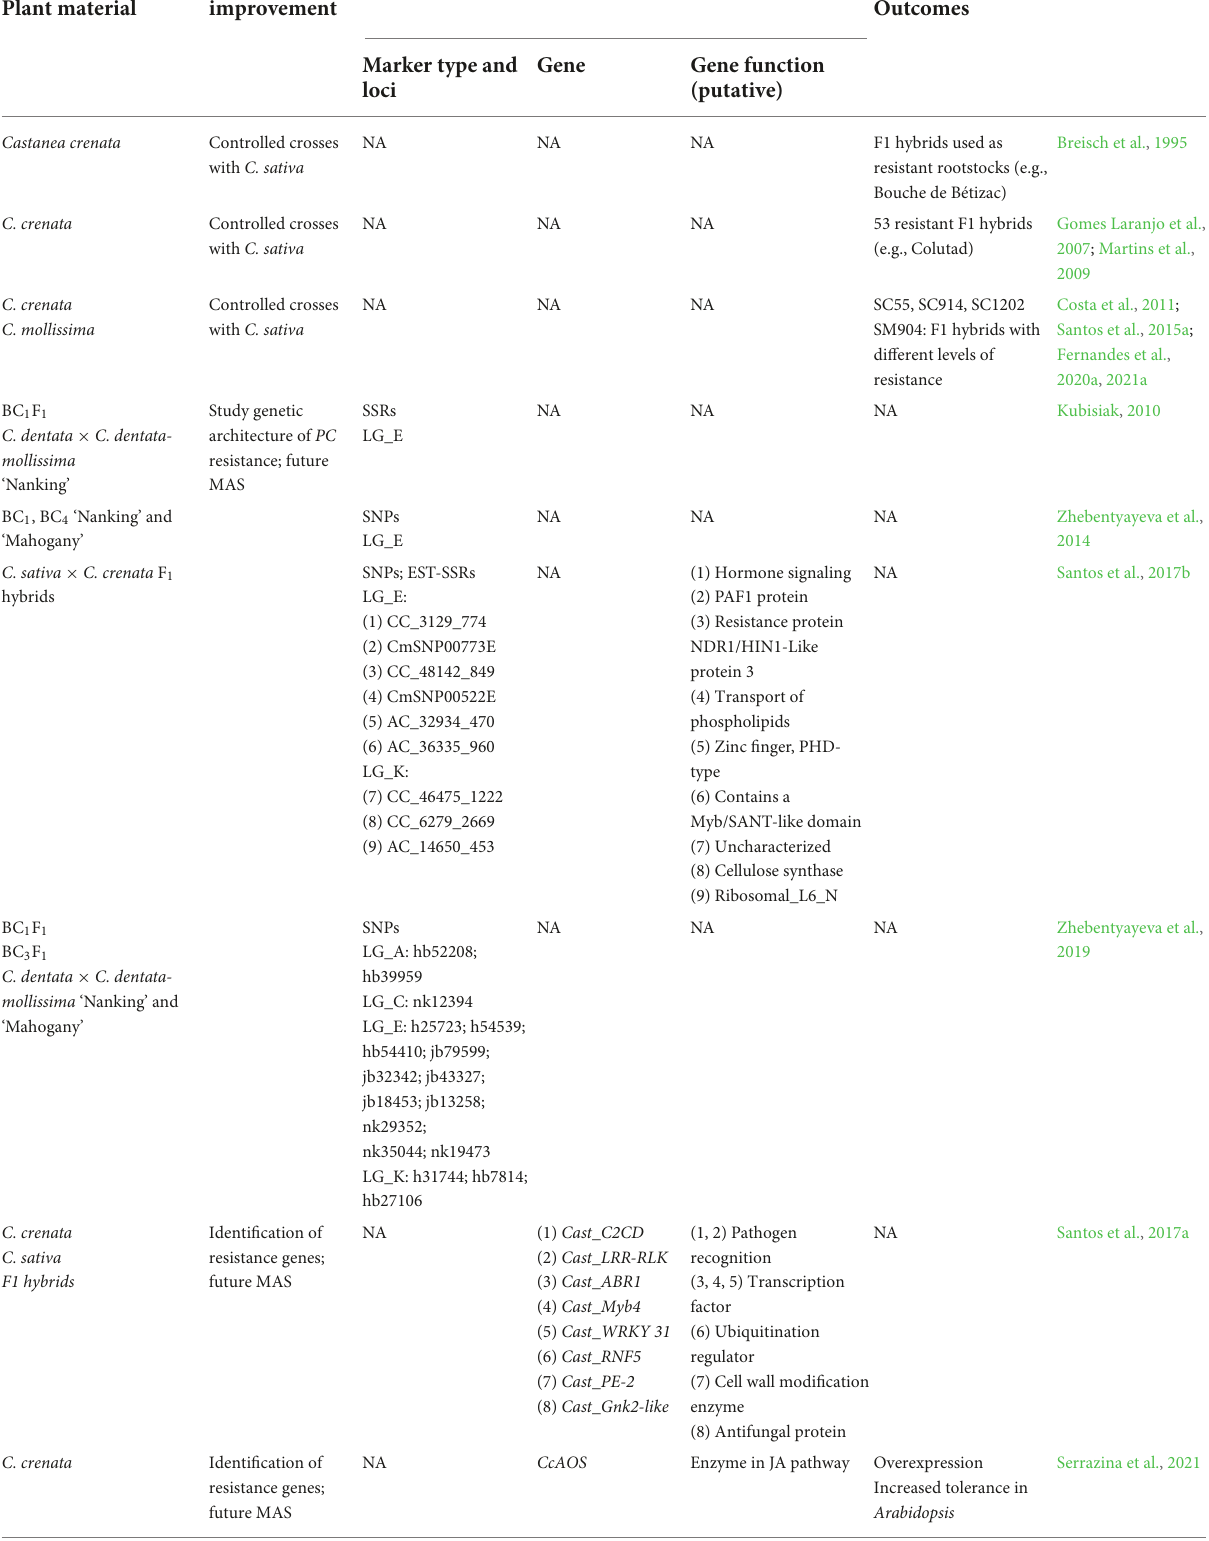
TABLE 2 Summary of efforts to control Phytophthora cinnamomi